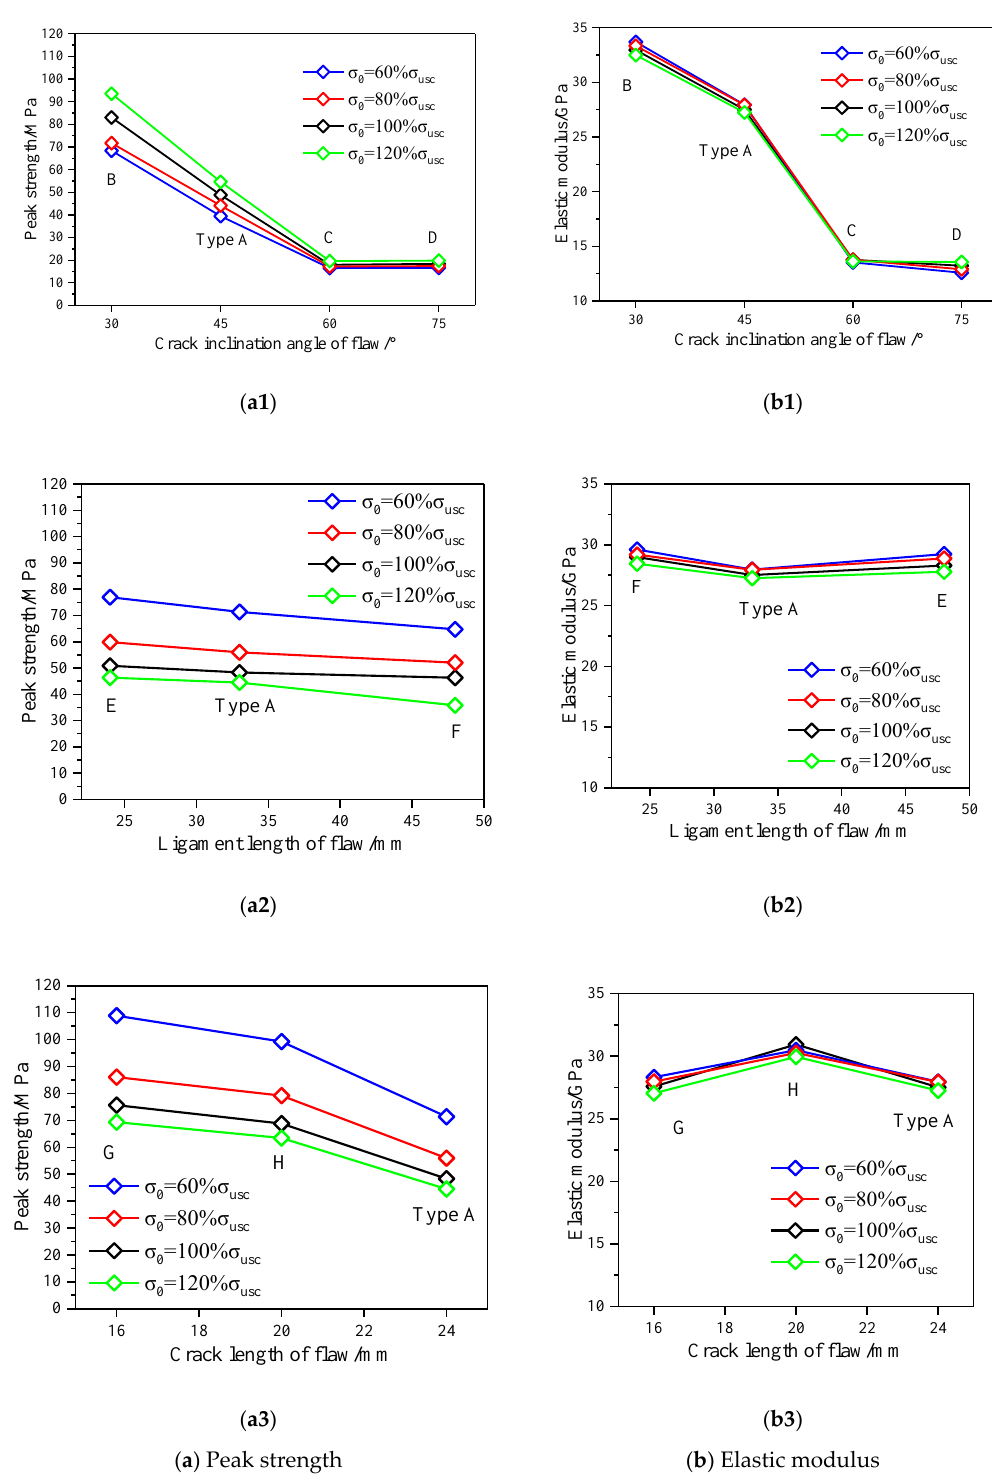
Figure 17. Effect of initial confining pressures on ( a ) peak strength and ( b ) elastic modulus. Figure 17. E ff ect of initial confining pressures on ( a ) peak strength and ( b ) elastic